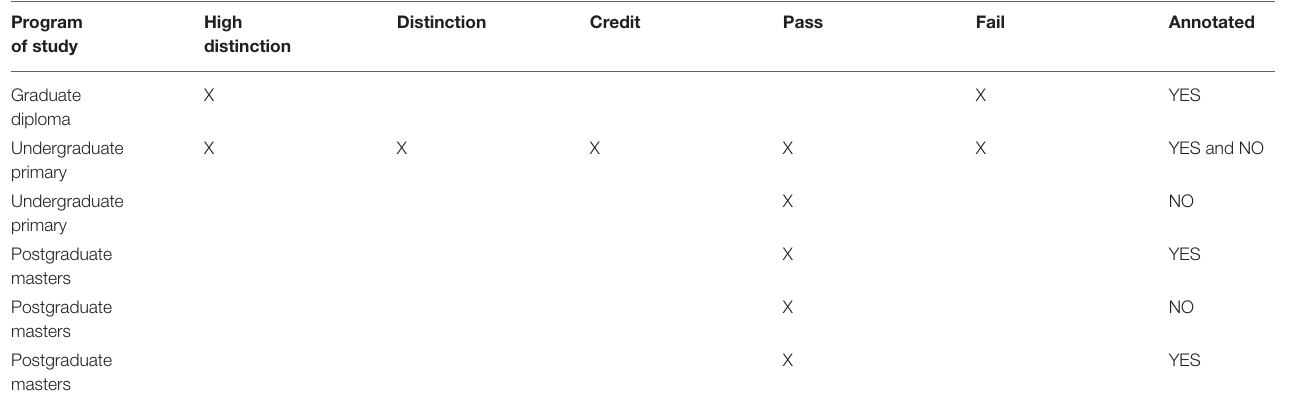
TABLE 1 | Summary of exemplars